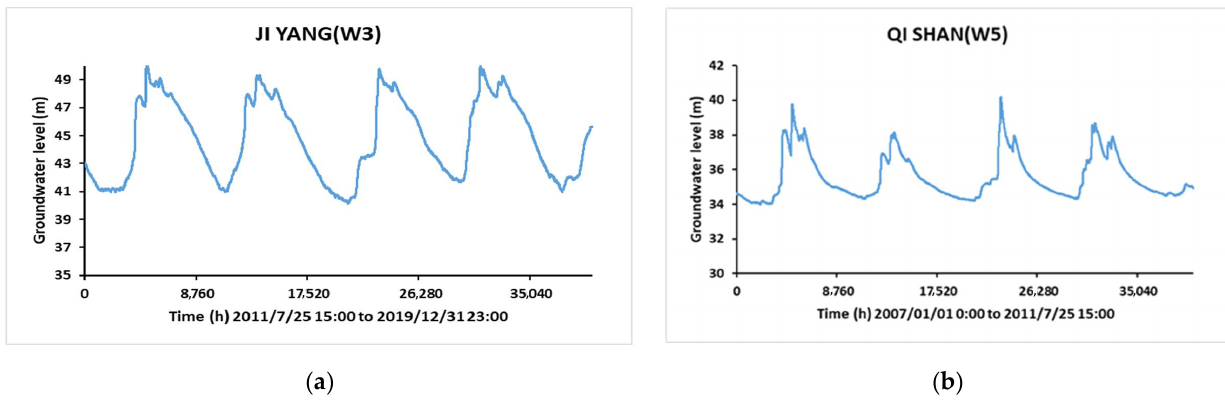
Figure 4. Identical annual curves of true hydrograph of successive years from two locations ( a ) V shape patterns at Ji-Yang (W3); ( b ) U shape patterns at Qi-Shan (W5).